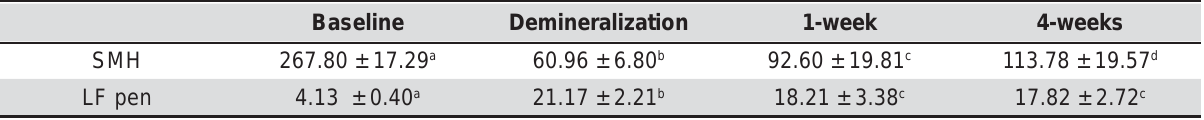
Table 2- (cid:3)(cid:54)(cid:88)(cid:85)(cid:73)(cid:68)(cid:70)(cid:72)(cid:3)(cid:80)(cid:76)(cid:70)(cid:85)(cid:82)(cid:75)(cid:68)(cid:85)(cid:71)(cid:81)(cid:72)(cid:86)(cid:86)(cid:3)(cid:89)(cid:68)(cid:79)(cid:88)(cid:72)(cid:86)(cid:3)(cid:73)(cid:82)(cid:85)(cid:3)(cid:80)(cid:76)(cid:70)(cid:85)(cid:82)(cid:75)(cid:68)(cid:85)(cid:71)(cid:81)(cid:72)(cid:86)(cid:86)(cid:3)(cid:87)(cid:72)(cid:86)(cid:87)(cid:3)(cid:68)(cid:81)(cid:71)(cid:3)(cid:192)(cid:88)(cid:82)(cid:85)(cid:72)(cid:86)(cid:70)(cid:72)(cid:81)(cid:70)(cid:72)(cid:3)(cid:89)(cid:68)(cid:79)(cid:88)(cid:72)(cid:86)(cid:3)(cid:73)(cid:82)(cid:85)(cid:3)(cid:47)(cid:41)(cid:3)(cid:83)(cid:72)(cid:81)(cid:3)(cid:76)(cid:81)(cid:3)(cid:71)(cid:76)(cid:73)(cid:73)(cid:72)(cid:85)(cid:72)(cid:81)(cid:87)(cid:3)(cid:87)(cid:76)(cid:80)(cid:72)(cid:3)(cid:83)(cid:82)(cid:76)(cid:81)(cid:87)(cid:86)(cid:3) (cid:11)(cid:80)(cid:72)(cid:68)(cid:81)(cid:3)(cid:147)(cid:3)(cid:54)(cid:39)(cid:12)(cid:3)(cid:11)(cid:81)(cid:32)(cid:22)(cid:19)(cid:12)